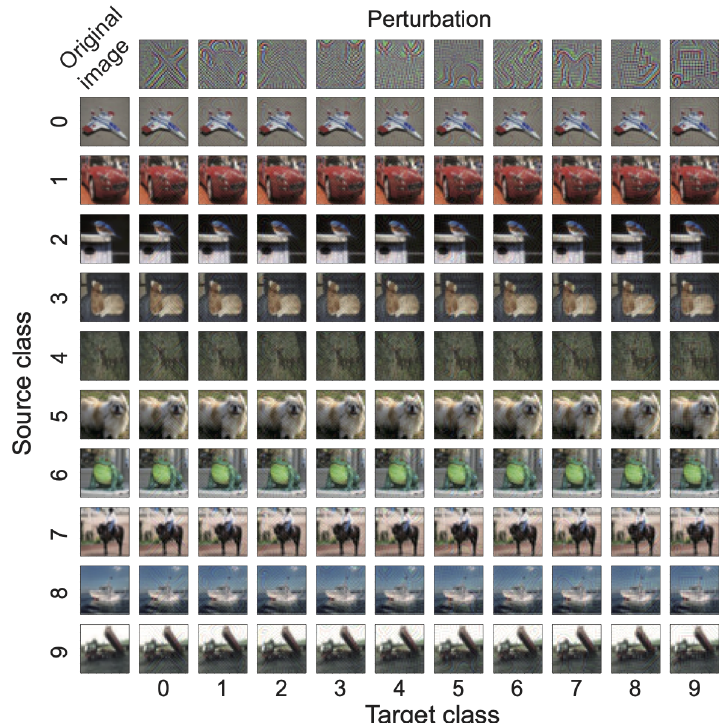
Figure 2. Targeted UAPs (top panel) with ζ = 5% against the VGG-20 model for the CIFAR-10 dataset and their adversarial attacks for an original (i.e., non-perturbed) image (left panel) randomly selected from the images that, without perturbation, was correctly classified into each source class and, with the perturbations, correctly classified into the target classes: airplane (0), automobile (1), bird (2), cat (3), deer (4), dog (5), frog (6), horse (7), ship (8), and truck (9). Note that the UAPs are emphatically displayed for clarity; in particular, each UAP was scaled with the maximum of one and the minimum of